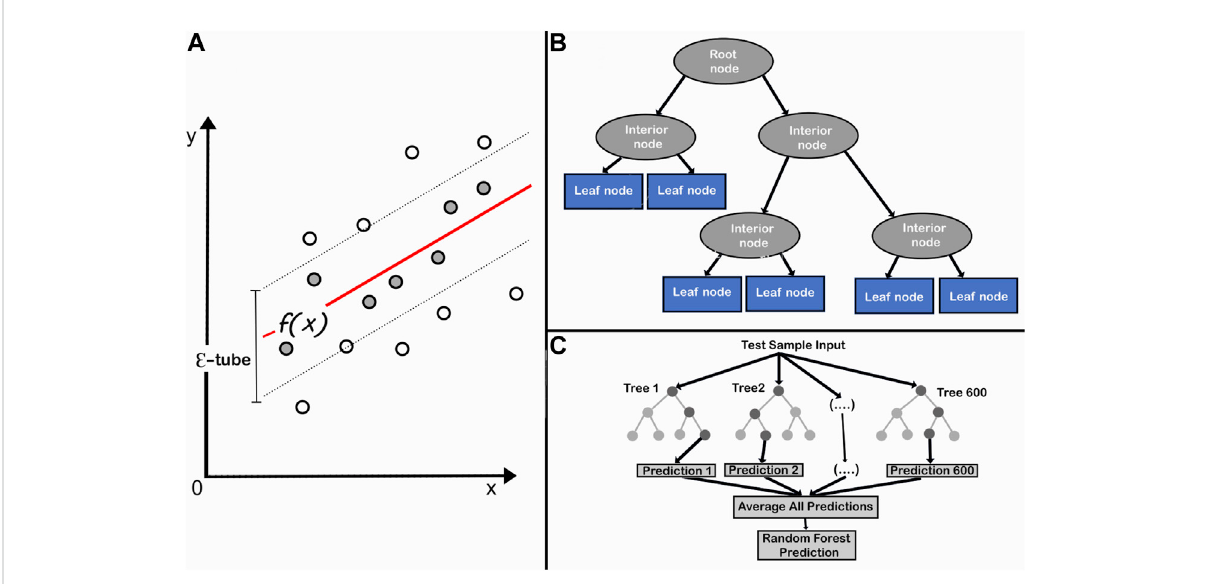
FIGURE 5 Supervised machine learning algorithms: (A) support vector regression (modi fi ed after Naganathan and Babulal, 2019), (B) decision tree regression (modi fi ed after Charbuty and Abdulazeez, 2021), and (C) random forest (modi fi ed after Rudd,